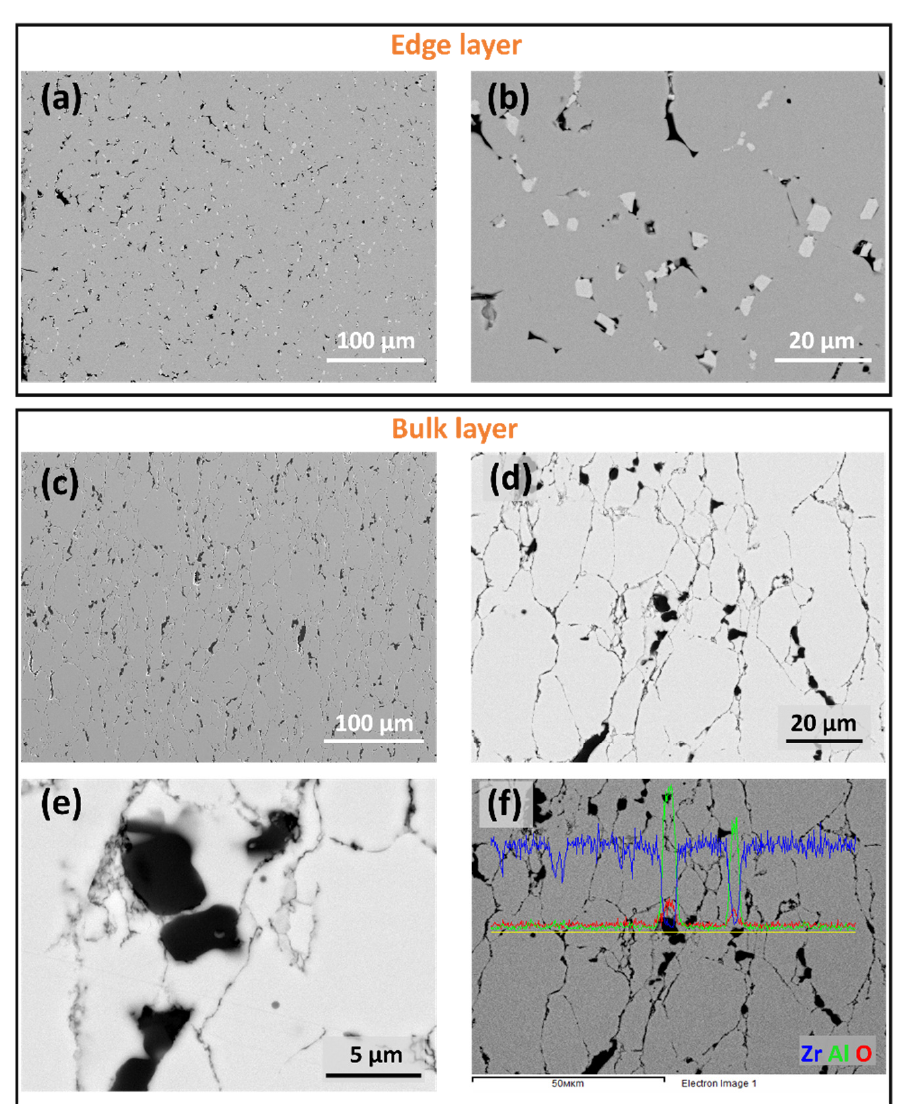
Figure 8. SEM images for 3 GAlN composite: ( a , b )—edge layer, ( c – e ) bulk layer; ( f ) EDS signal for Zr, Al, O elements, measured along the sample.